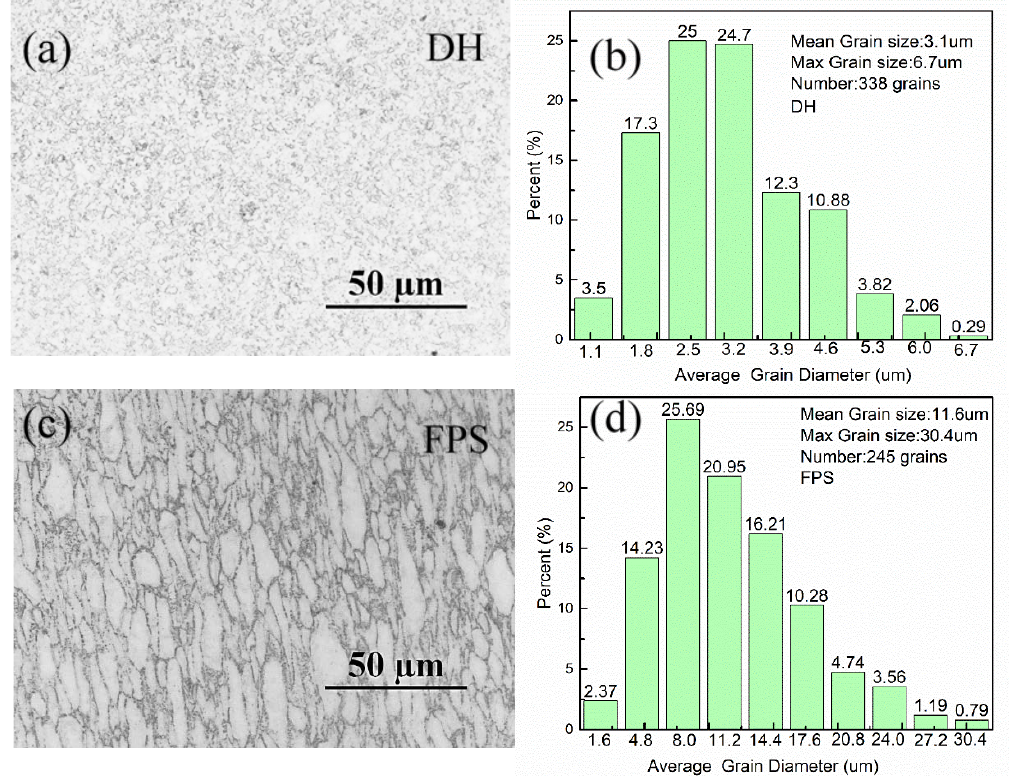
Figure 3. Optical microstructure ( a , c ) and the measured grain size distribution ( b , d ).